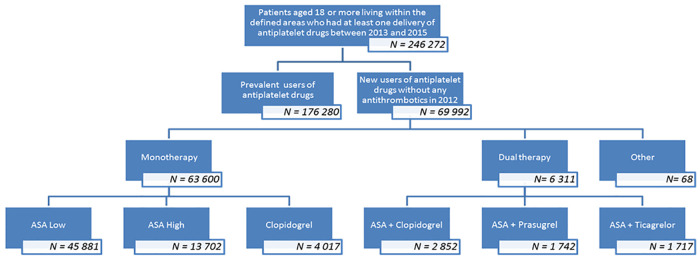
Inclusion flow chart.